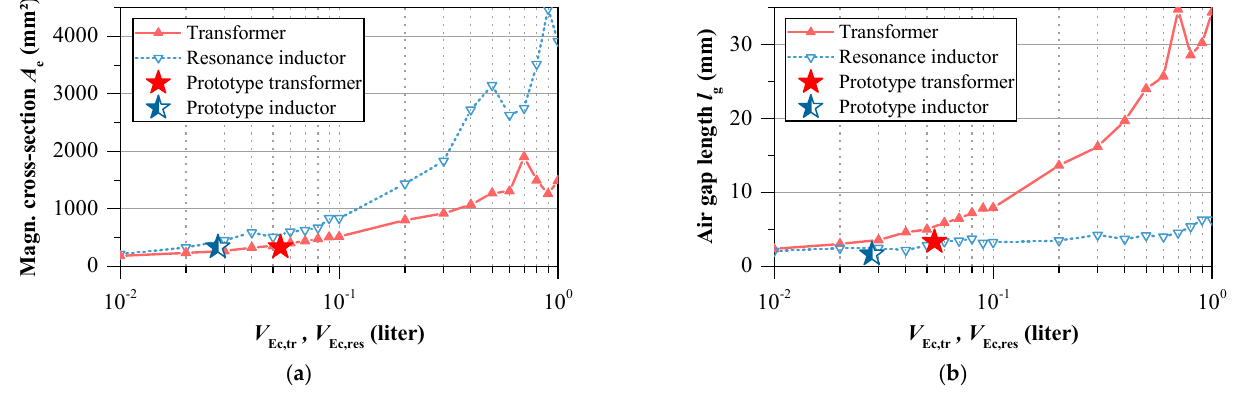
Figure 19. Efficiency-optimal design parameters of the inductive components as a function of volume V Ec,x and under consideration of the boundary conditions in Table 7. ( a ) Effective magnetic cross-section A e and ( b ) length of the air gap l g . For the transformer, N p = 16 is selected.